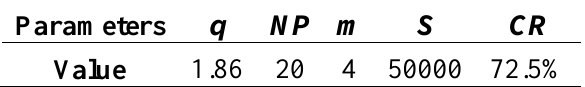
Table 2. The optimal parameters used in face recognition.